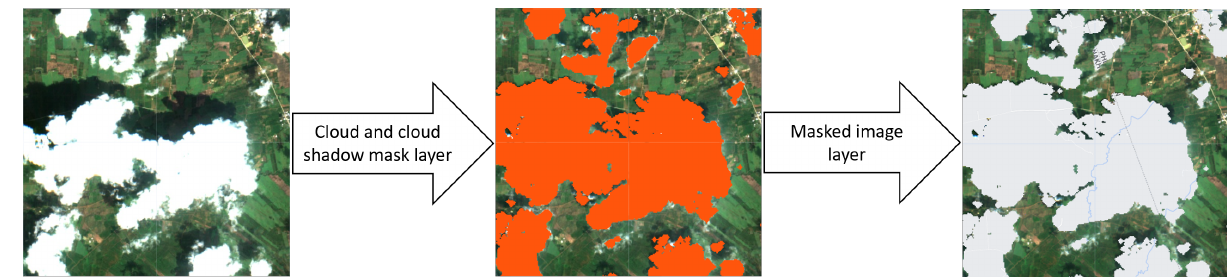
Figure 3. Process of cloud and cloud shadow masking on Sentinel-2A image. The image used is a subset of a satellite image with midpoint coordinates (100.810481341, 15.77135789630) obtained on Friday, 8 October 2021, 10:53:57.445 AM Indochina